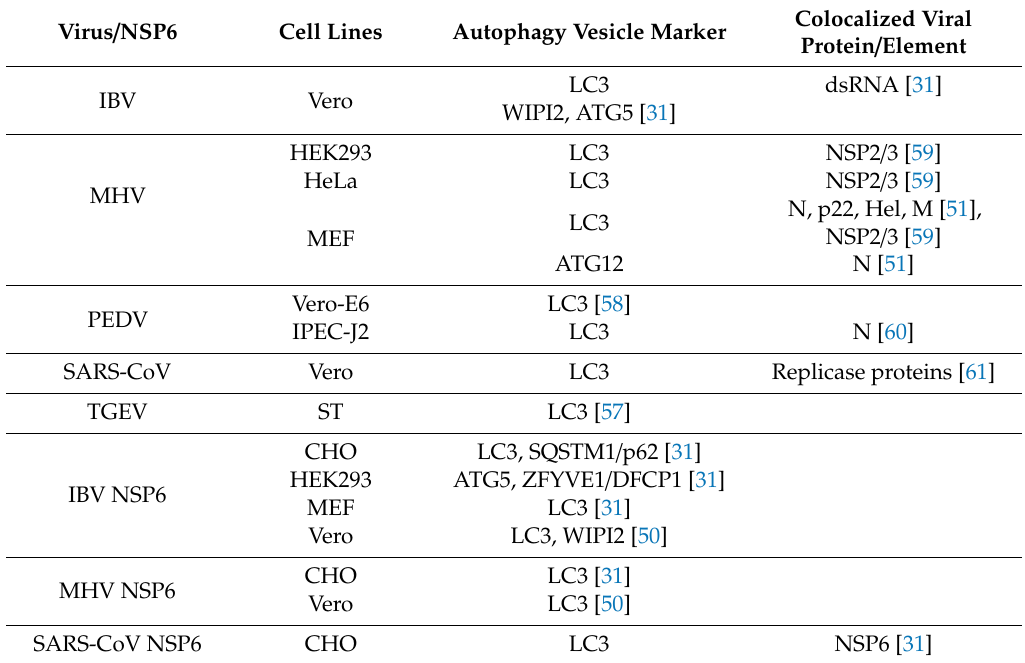
Table2. Autophagymarkersandcolocalizingviralelementsdetectedinvesiclesinducedbycoronavirus. Virus / NSP6 Cell Lines Autophagy Vesicle